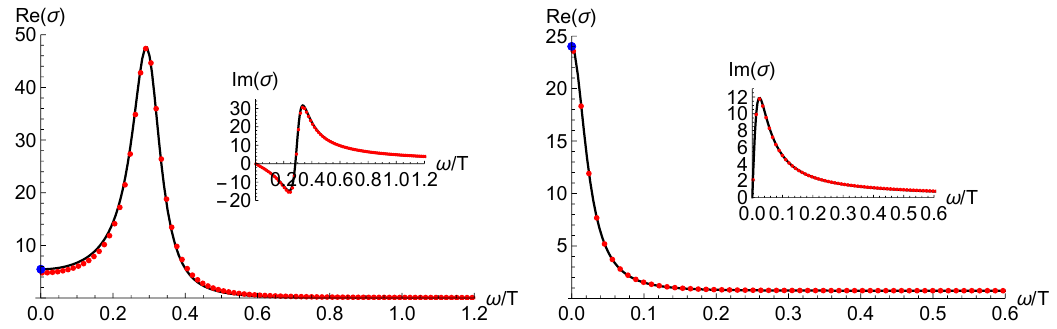
√ ρ = 0 . 3 . We have fixed